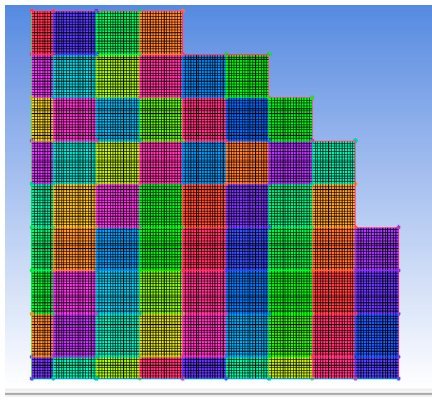
Figure 2. The mesh of benchmark IAEA 2D PWR. Table 1. The k eff calculation result of IAEA-2D PWR.